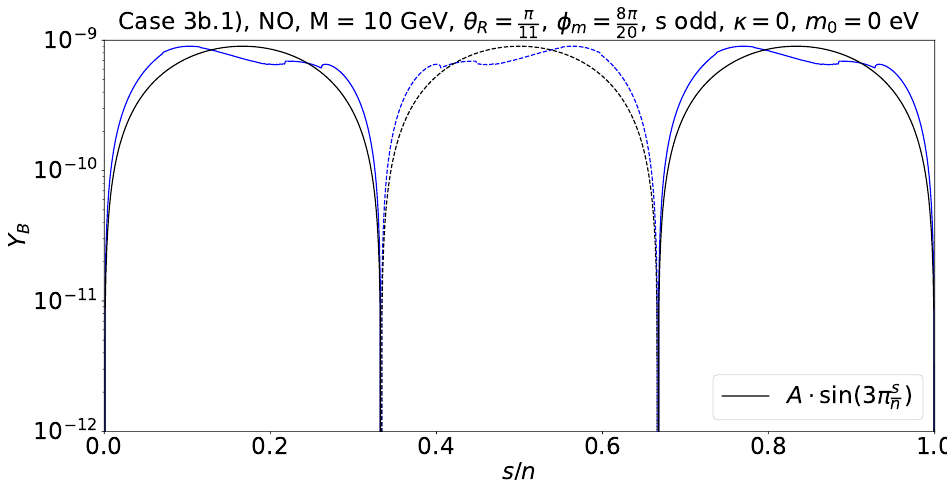
, treated as continuous parameter, for a Majorana n , θ = π . The splitting κ (and λ ) vanishes. Light R R 11 , DEG ,α (cid:3) . Both negative (dashed B |